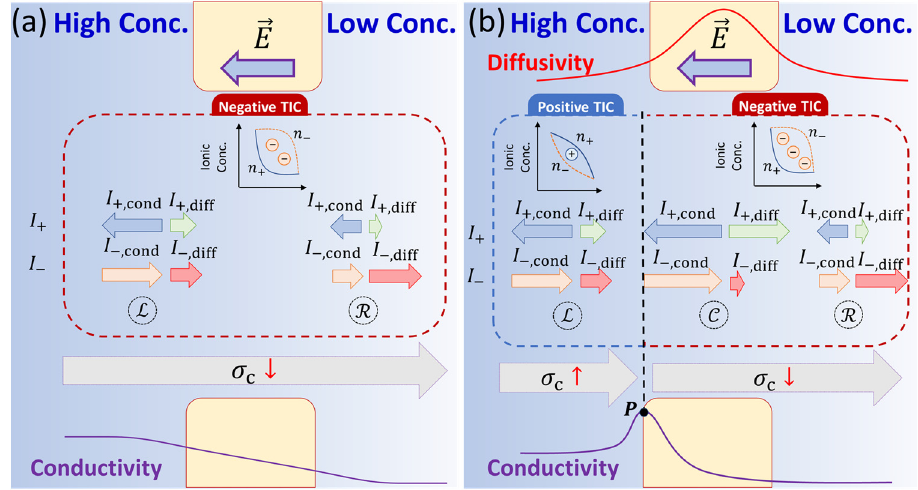
Figure 4. Schematic (not to scale) explanation of ( a ) negative TIC in an isothermal nanopore under the influence of only ion concentration gradient, and ( b ) combination of positive and negative TIC in a nanopore under the dual influence of ion concentration gradient and temperature hotspot formed as a result of Joule heating.